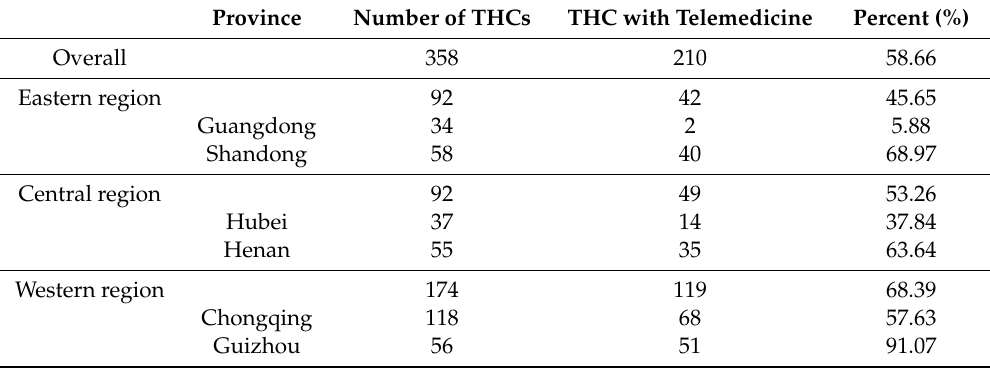
Table 1. Application of telemedicine among the investigated township health centres